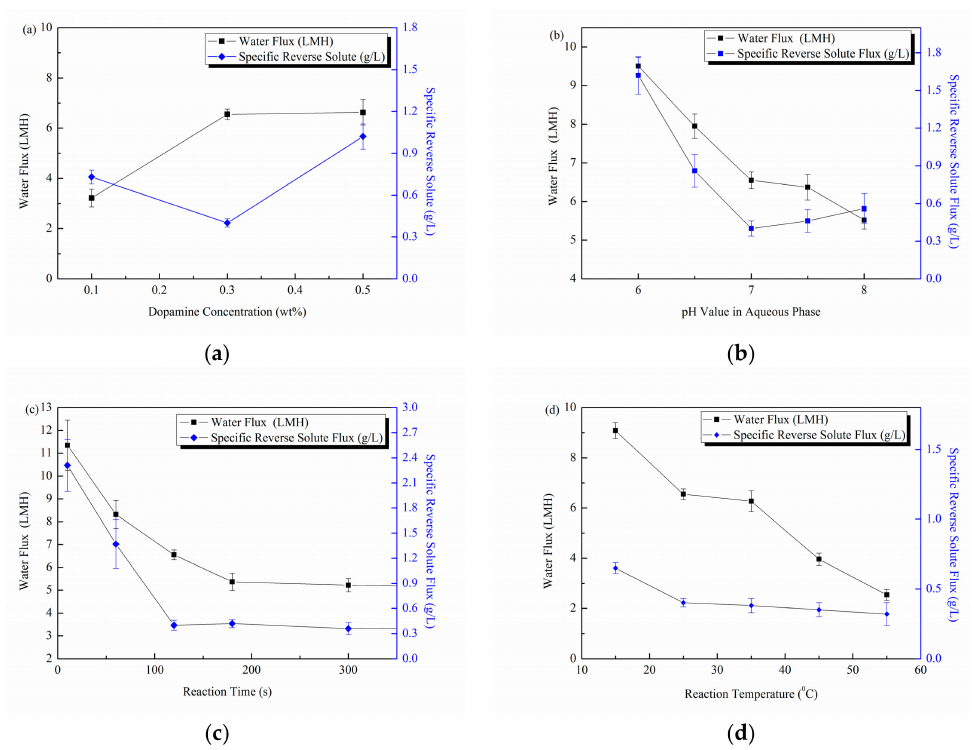
Figure 4. ( a ) The influence of dopamine (DA) concentration (0.1 wt%, 0.3 wt% and 0.5 wt%) in aqueous phase on the forward osmosis (FO) performance of the DA/trimesoyl chloride (TMC) TFC membranes; ( b ) The influence of pH value (6, 6.5, 7, 7.5 and 8) in aqueous phase on the FO performance of the DA/TMC TFC membranes; ( c ) The influence of reaction time (10–300 s) on the FO performance of the DA/TMC TFC membranes and ( d ) The influence of temperature (15, 25, 35, 45 and 55 ◦ C) in aqueous phase on the FO performance of the DA/TMC TFC